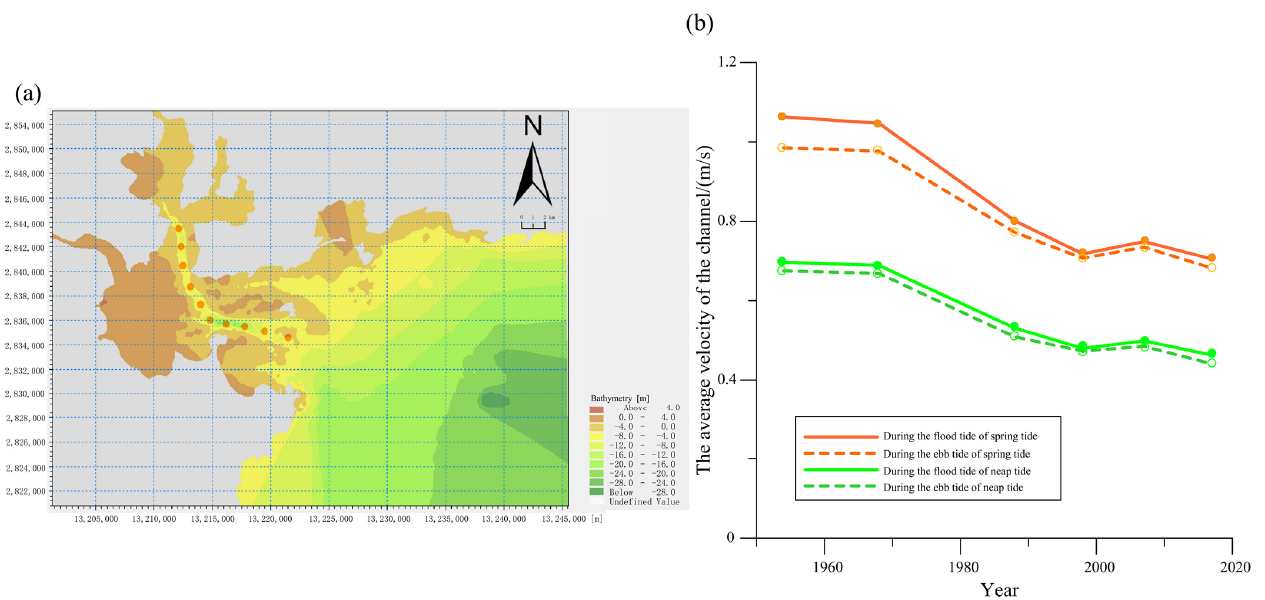
Figure 6. Changes in tidal current field of the flood and ebb tides in Quanzhou Bay during different periods. ( a ) Tidal current velocity calculation point distribution location; ( b ) The average velocity of the channel area in different years.